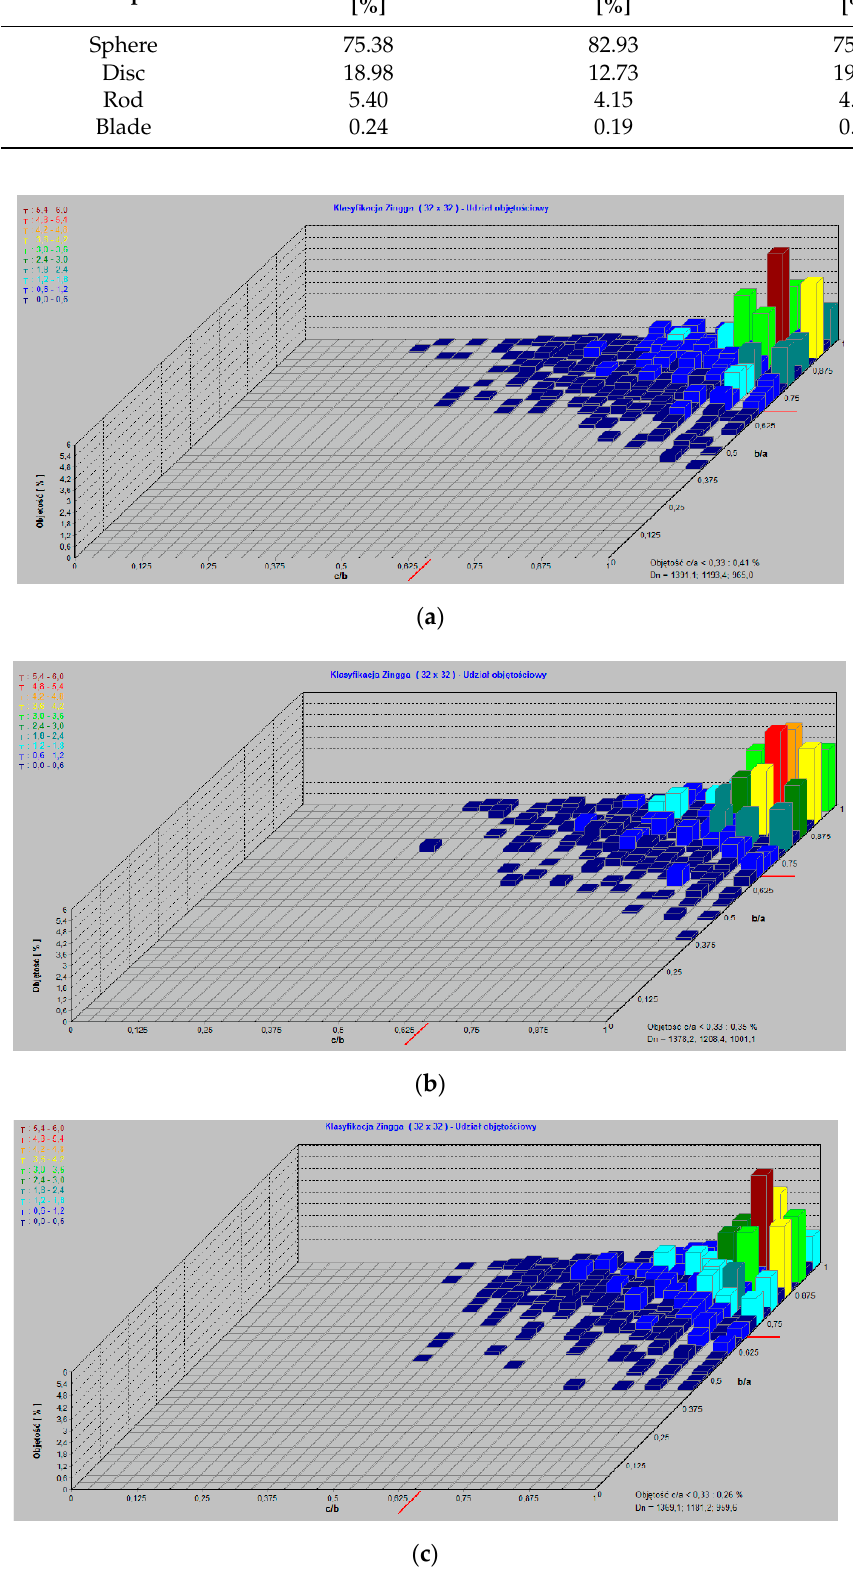
Figure 4. Zinng classification of ( a ) THA, ( b ) ZH and ( c ) THA.